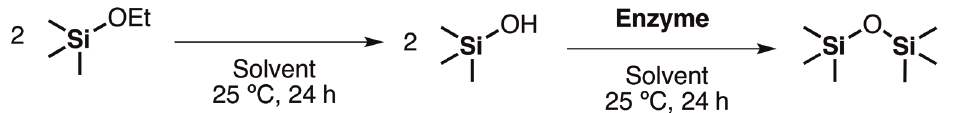
Figure 57 - Screening of enzymes for siloxane bond formation in aqueous or organic solvent media.